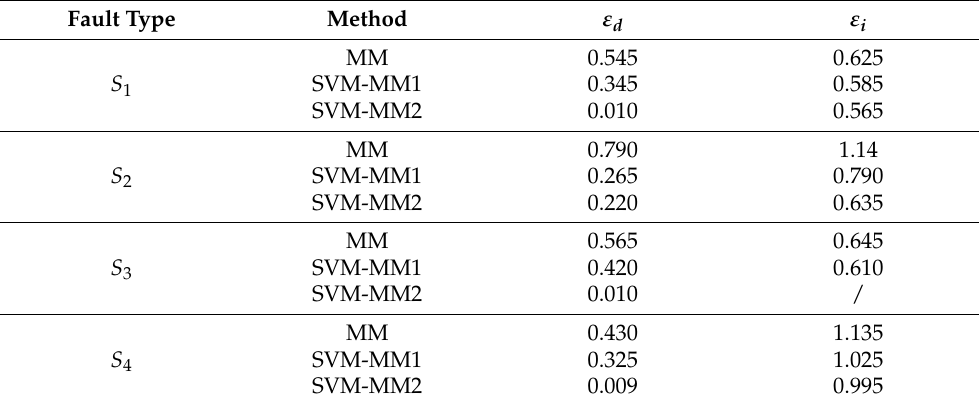
Table 3. Single-Failure Diagnosis Performance